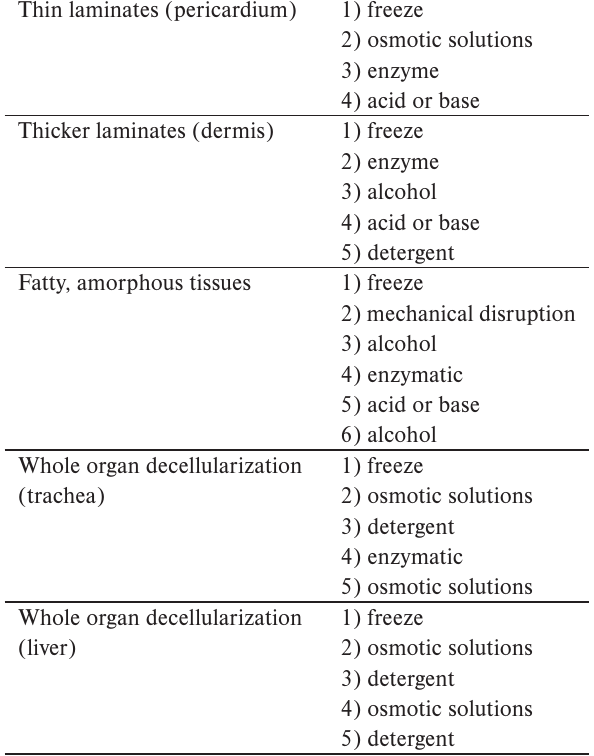
Table 1. Example of decellularization protocols 22 . Thin laminates